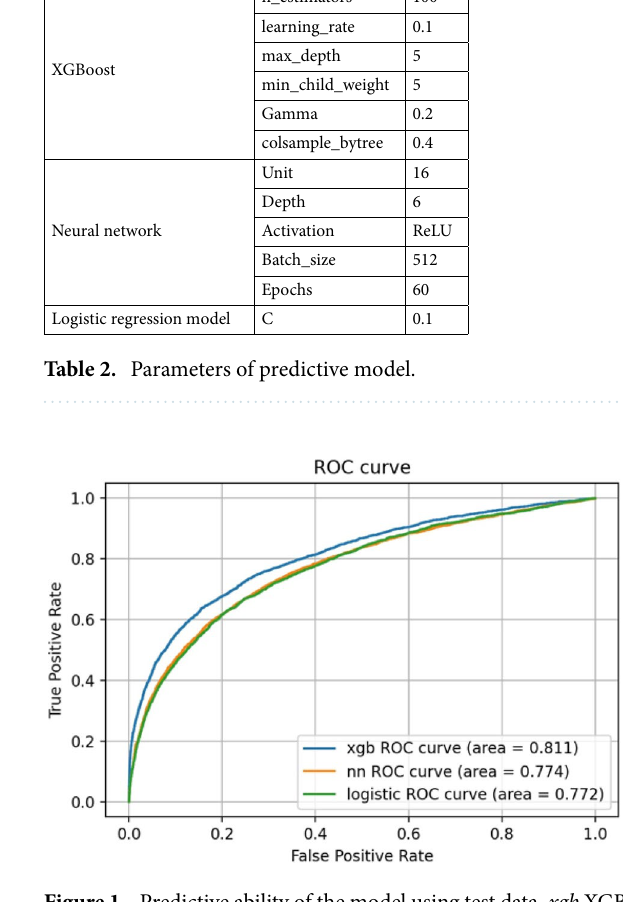
Figure 1. Predictive ability of the model using test data. xgb XGBoost, nn neural network.